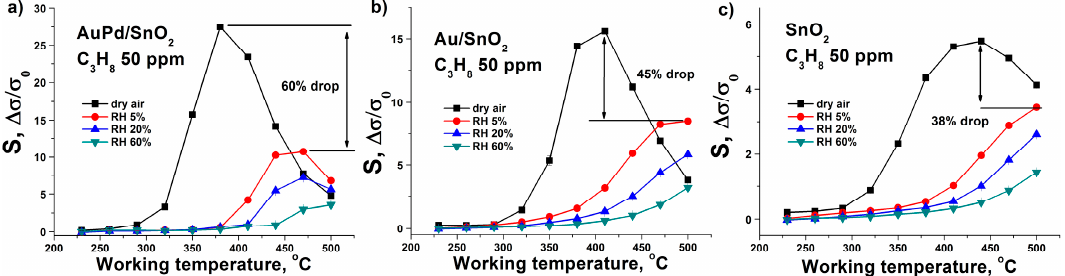
Figure 7. Sensor response dependence on the air humidity for 50 ppm of C 3 H 8 in the case of ( a )